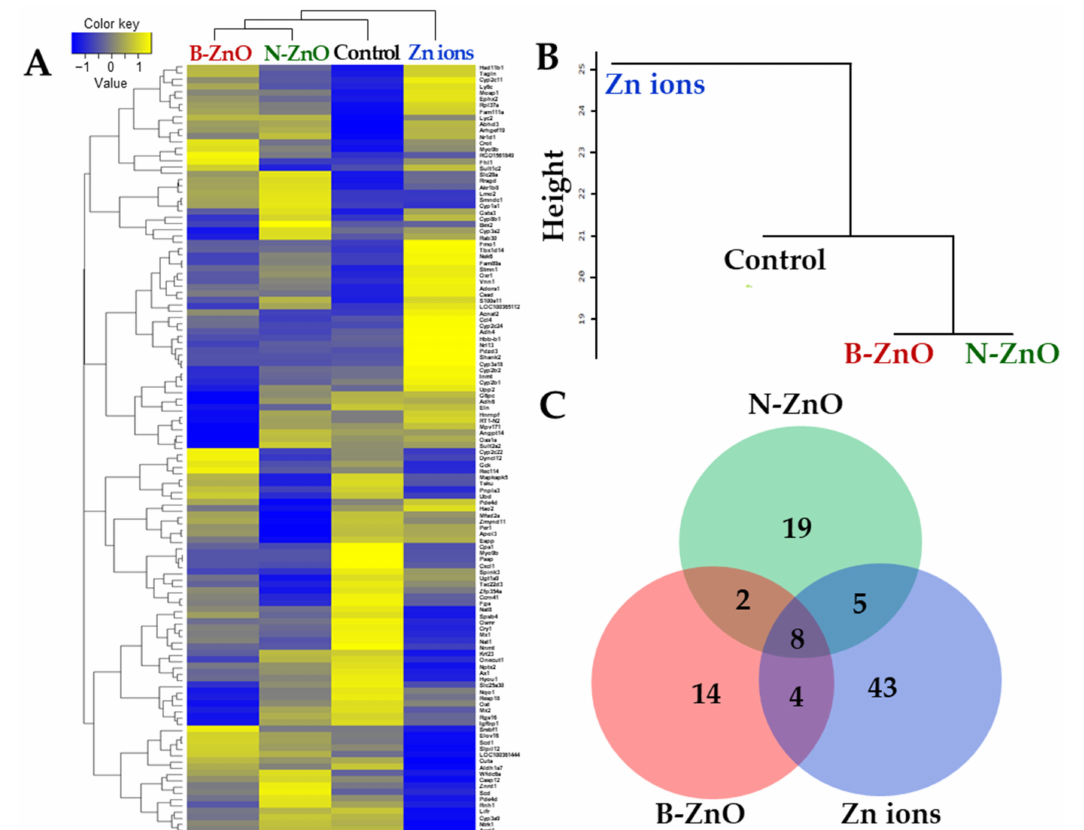
Figure 5. RNA sequencing analysis in the rat livers after 14-day repeated oral administration of B-ZnO, N-ZnO or Zn ions. ( A ) The heat map, ( B ) dendrogram of hierarchical clustering, and ( C ) Venn diagram of differentially expressed genes (DEGs) satisfying with two-fold changes (>2 or < −